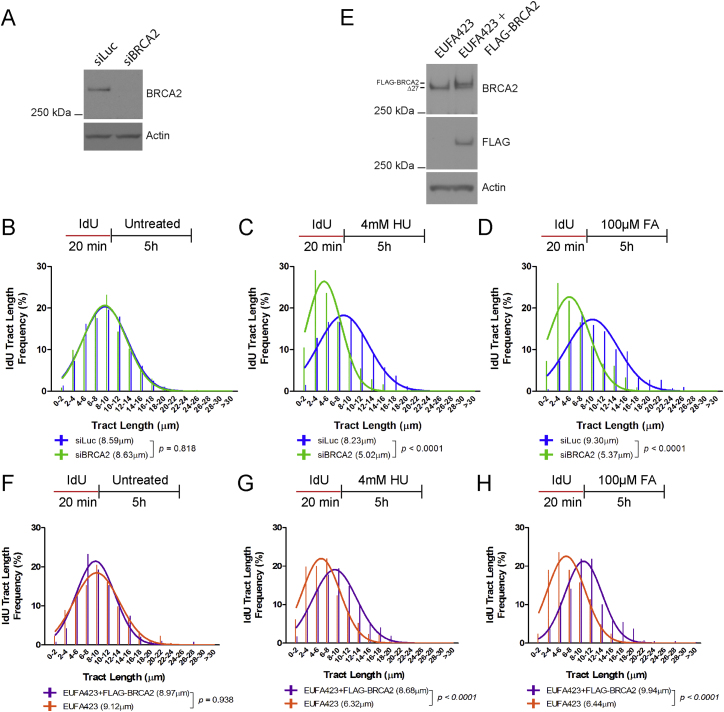
Related to Figure 2(A) BRCA2 protein levels in wild-type HeLa Kyoto cells 24h after transfection with 50nM short interfering RNAs to Luc (siLuc) or BRCA2 (siBRCA2).(B–D) IdU tract length frequency distributions of wild-type HeLa Kyoto cells treated with (siBRCA2) or without (siLuc) BRCA2 knockdown under the indicated conditions.(E) BRCA2 protein levels in EUFA423 cells and EUFA423 cells complemented with FLAG-BRCA2. Δ27 refers to the exon 27 truncated variant from the BRCA2 9900insA mutant allele. The truncated product from the BRCA2 7691insAT allele was not detectable.(F–H) IdU tract length frequency distributions of EUFA423 cells, with or without FLAG-BRCA2 complementation, treated under the indicated conditions. Results in (B)–(D) and (F)–(H) represent two independent experiments.